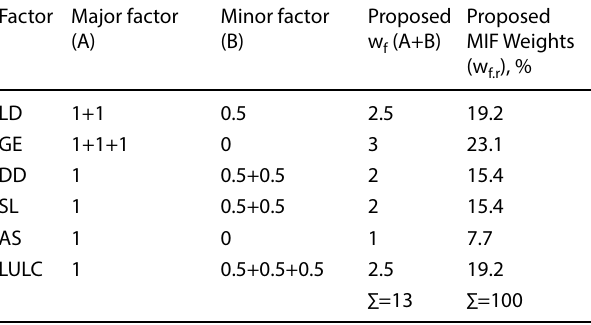
Table 2 Effect of influencing factors, relative rates and score for each potential factors Factor Major factor